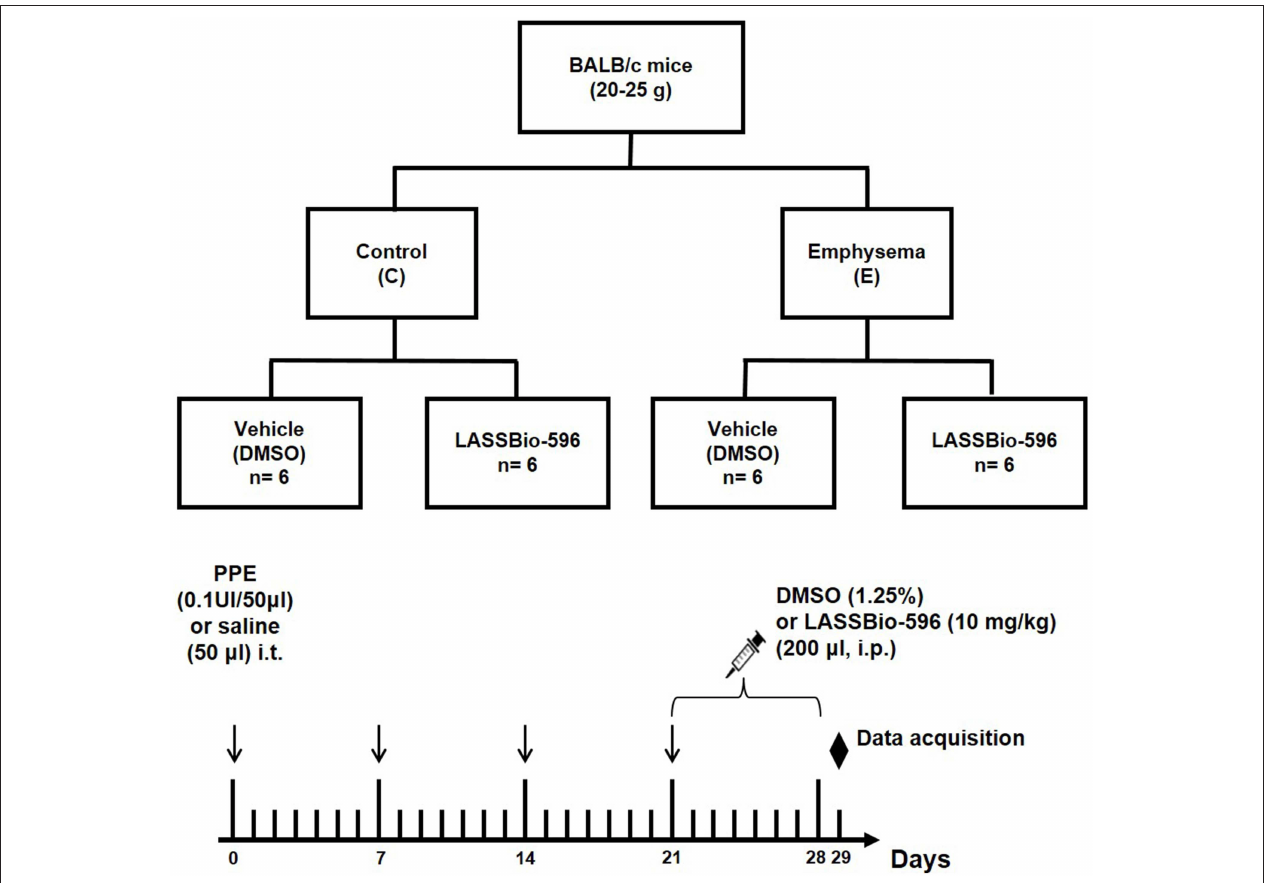
FIGURE 1 | Flowchart and timeline of study design. Control (C), four intratracheal administrations of saline; Emphysema (E), four intratracheal administrations of porcine pancreatic elastase (PPE); DMSO, vehicle (dimethyl sulfoxide)—intraperitoneal treatment with DMSO for 8 days; LASSBio-596, intraperitoneal treatment with LASSBio-596 for 8 days. All data were analyzed on day